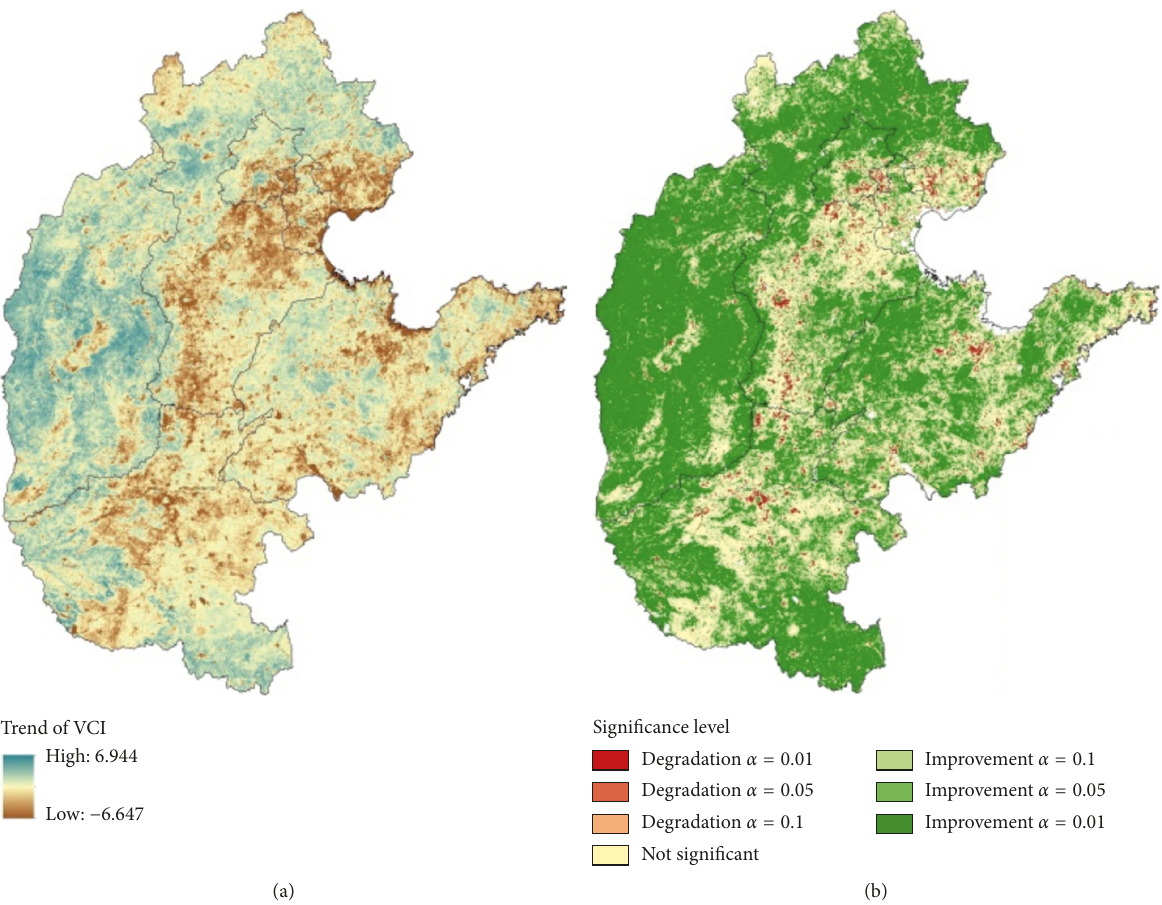
Figure 8: Annual trend and significance level of VCI in North China during